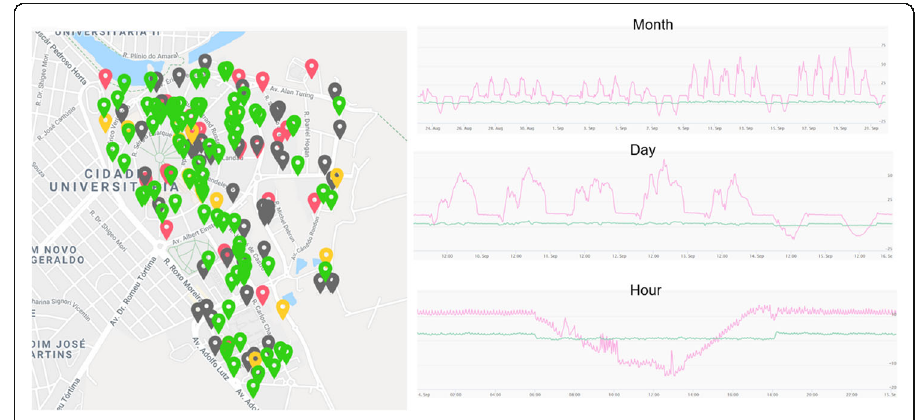
Fig. 4 Power system operation center